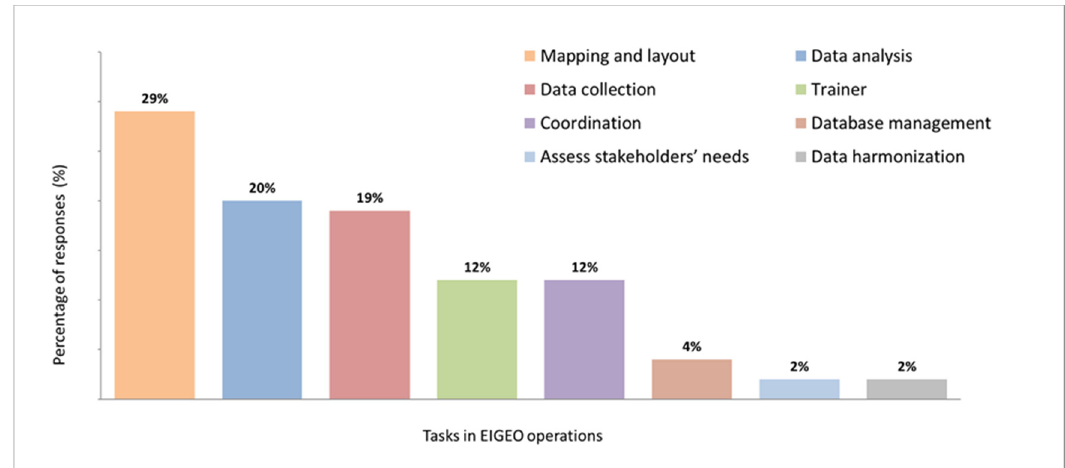
Figure 7. Distribution of responses by participant tasks (Q9). Note: Multiple answers allowed .